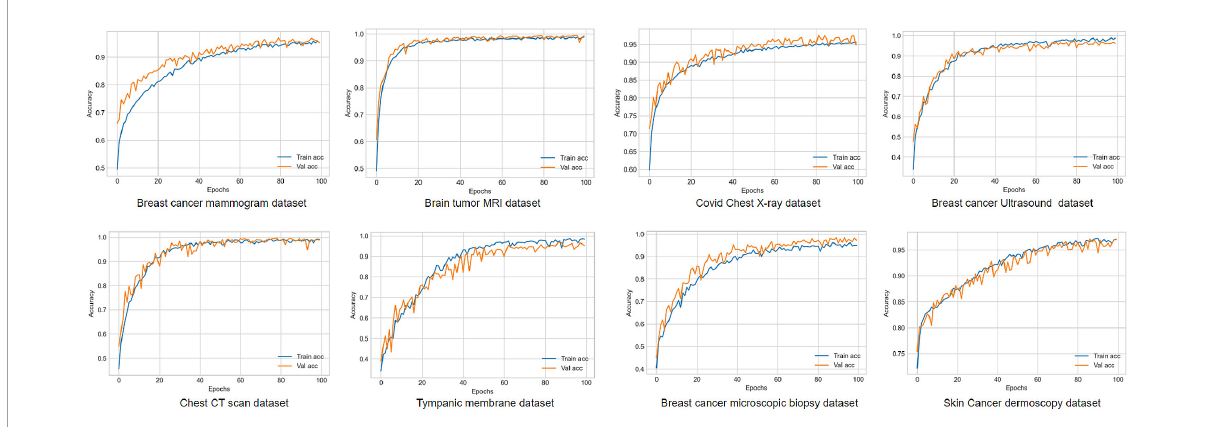
FIGURE8 Accuracy curves for all the eight medical image datasets trained on proposed